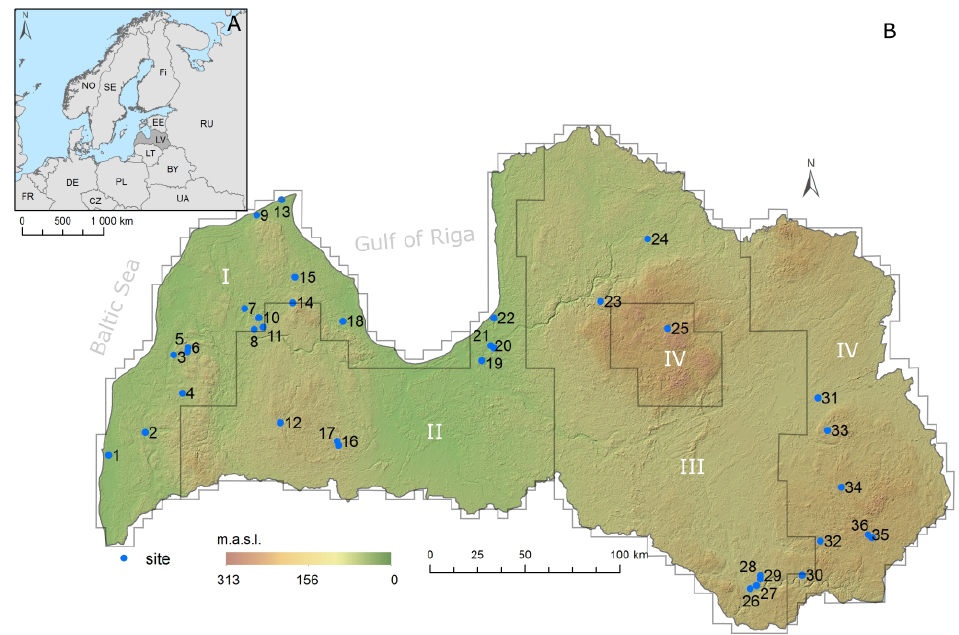
Figure 1. Study area in Europe ( A ) and the location of waterbodies in Latvia used in current article